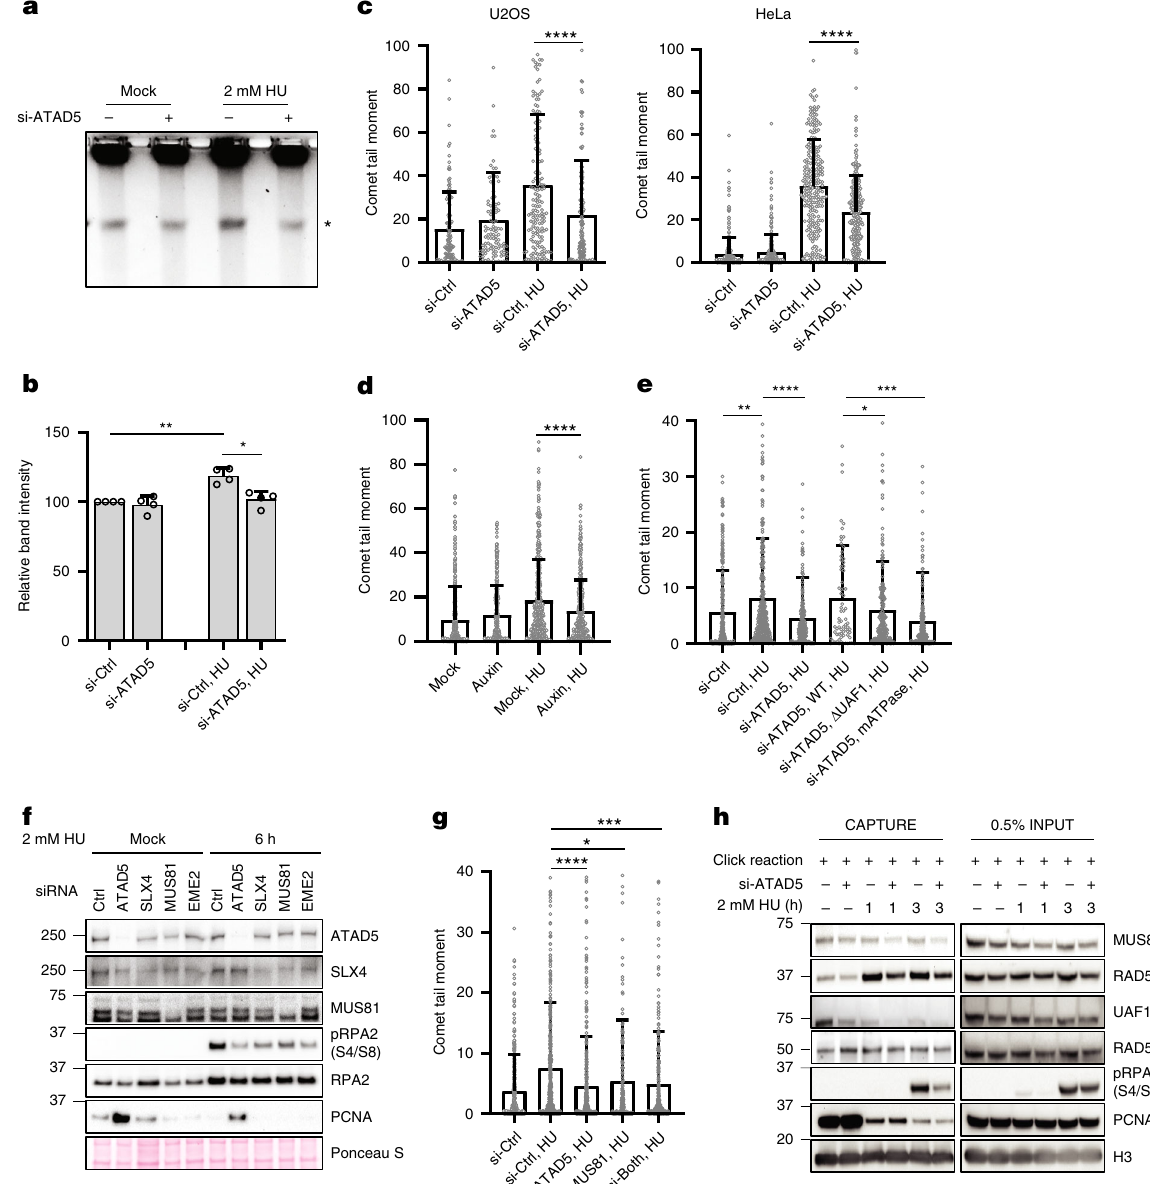
Fig. 5 ATAD5 promotes generation of MUS81-mediated single-stranded DNA-associated breaks in response to replication stress. a , b U2OS cells transfected with ATAD5 siRNA under the Noco-APH condition were treated with 2 mM HU for 6 h before being collected for analysis by pulsed fi eld gel electrophoresis. a Representative data from three independent experiments. Asterisk (*) indicates a DNA break. b DNA breaks were quanti fi ed and displayed ( N = 4). c U2OS or HeLa cells transfected with ATAD5 siRNA under the Noco-APH condition were treated with 2 mM HU for 6 h before being collected for a neutral COMET assay. The tail moment was calculated from ~200 cells and plotted. d U2OS cells expressing ATAD5 AID were pre-treated with auxin and treated with 2 mM HU for another 6 h before being collected for a neutral COMET assay. Two independent experiments were performed, and one representative result is displayed. e U2OS-TetOn-ATAD5 cells treated with doxycycline for 24 h before entering the Noco-APH condition were treated with 2 mM HU for 6 h before collection for the neutral COMET assay. f U2OS cells transfected with siRNAs under the Noco-APH condition were treated with 2 mM HU for 6 h. Chromatin-bound proteins were fractionated and subjected to immunoblotting. g U2OS cells transfected with a combination of ATAD5 and MUS81 siRNAs under the Noco-APH condition were treated with 2 mM HU for 6 h before collection for the neutral COMET assay. The tail moment was calculated from ~300 cells and plotted. h HEK293T cells transfected with ATAD5 siRNA for 48 h were labeled with 10 μ M EdU for 20 min, washed, and treated with 2 mM HU for the indicated times. Samples were processed for iPOND, and captured proteins were separated by SDS-PAGE and immunoblotted. b – e , g Error bars represent standard deviation of the mean. Statistical analysis: two-tailed Student ’ s t test; * p < 0.05, ** p < 0.005, *** p < 0.001, and **** p <